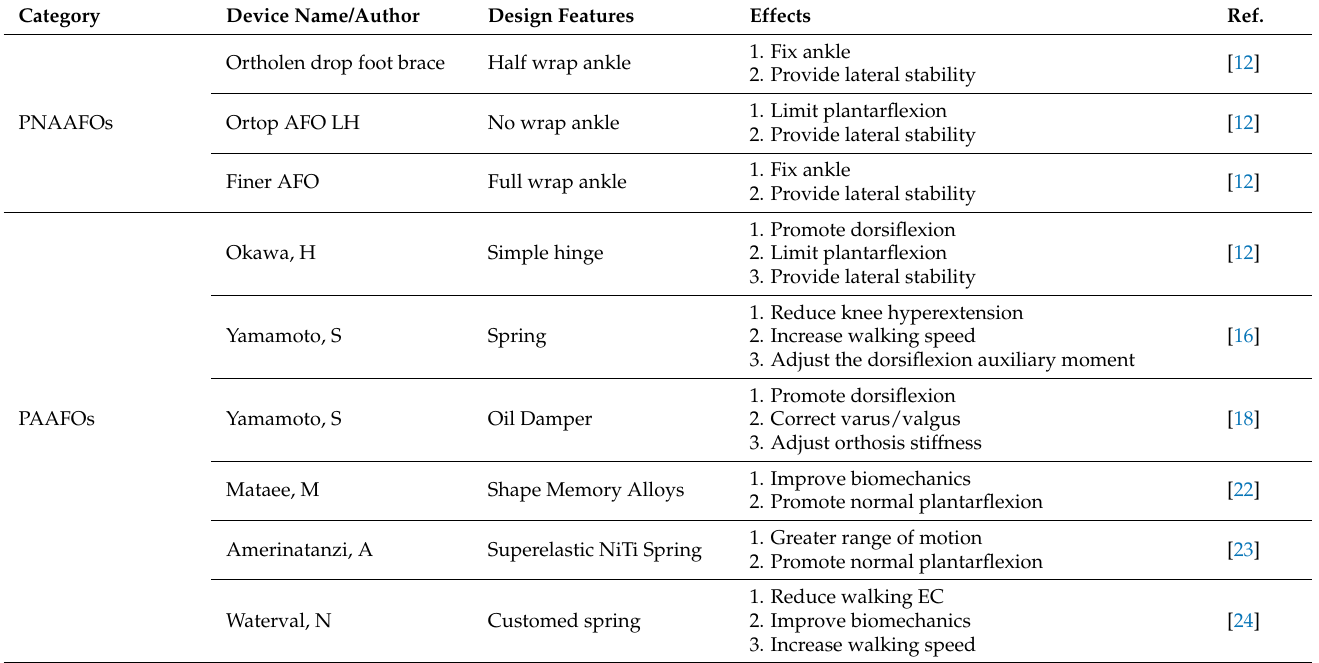
Table 1. Comparison of features and functions between PNAAFOs and